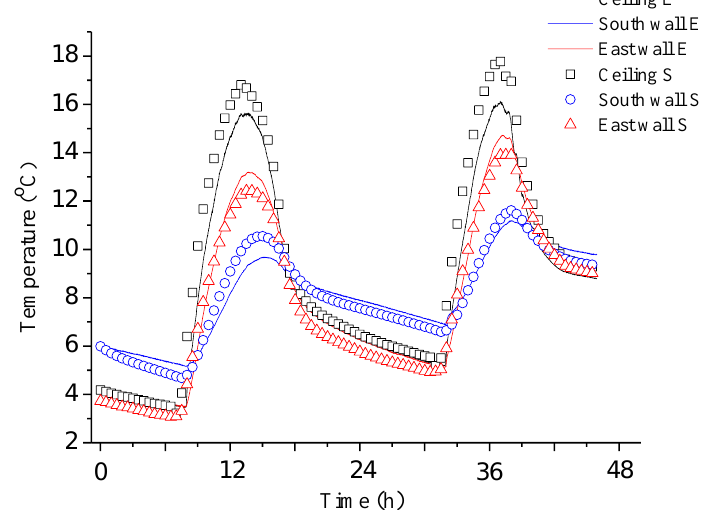
Figure 8. Comparison of measured and predicted temperatures of the building envelope (E—experiment; S—simulation).